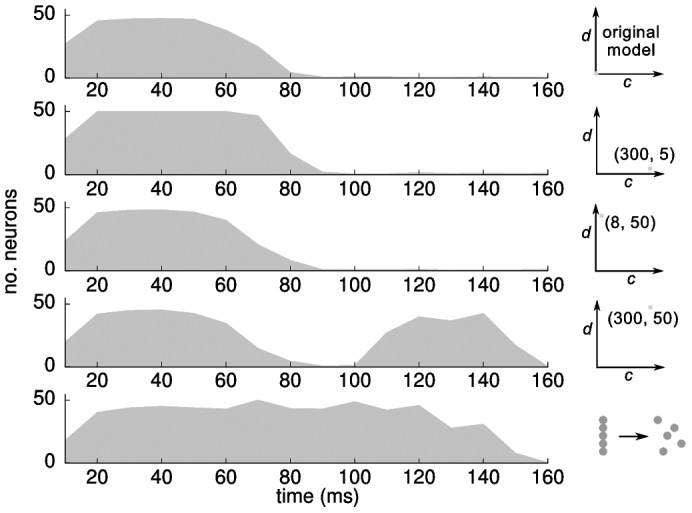
Influence of anatomical properties of the hippocampal loop on the capability to associate patterns across.Each plot depicts the number of target neurons that are activated during recall as a function of the temporal separation between the cue and target patterns during training. From top to bottom: original model by Izhikevich [18], hippocampal loop with high connectivity/low delay, low connectivity/high delay, high connectivity/high delay, and high connectivity/high delay+temporal dispersion.